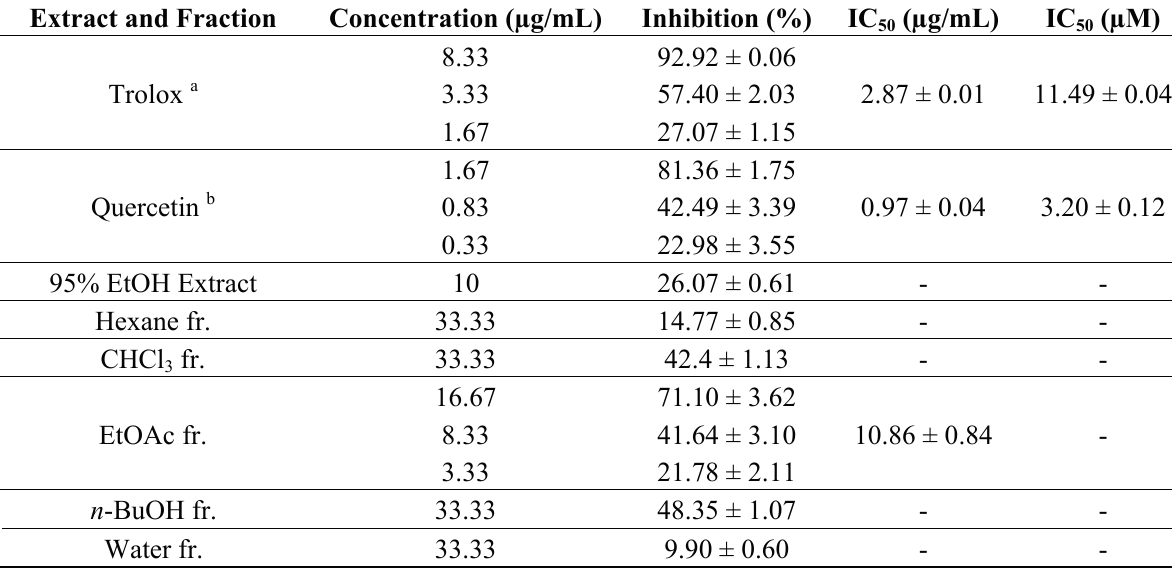
Table 4. Antioxidant effects of the Colocasia esculenta (L.) Schott on inhibition of the ABTS +